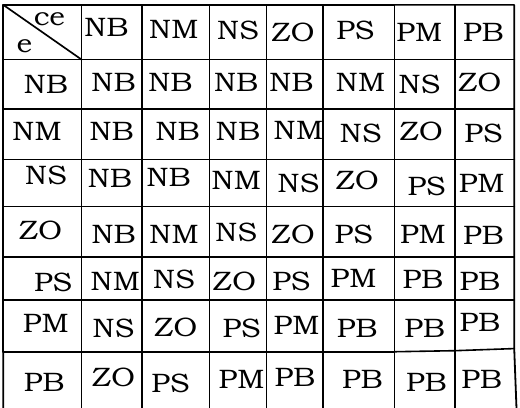
Table 1. Rule Based System of Fuzzy